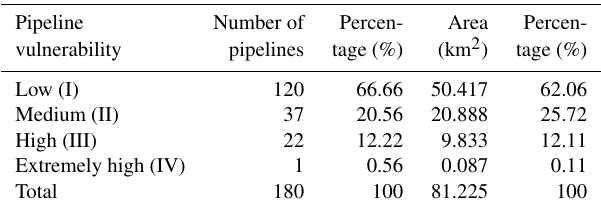
Table 4. Number and distances of pipeline of four vulnerability